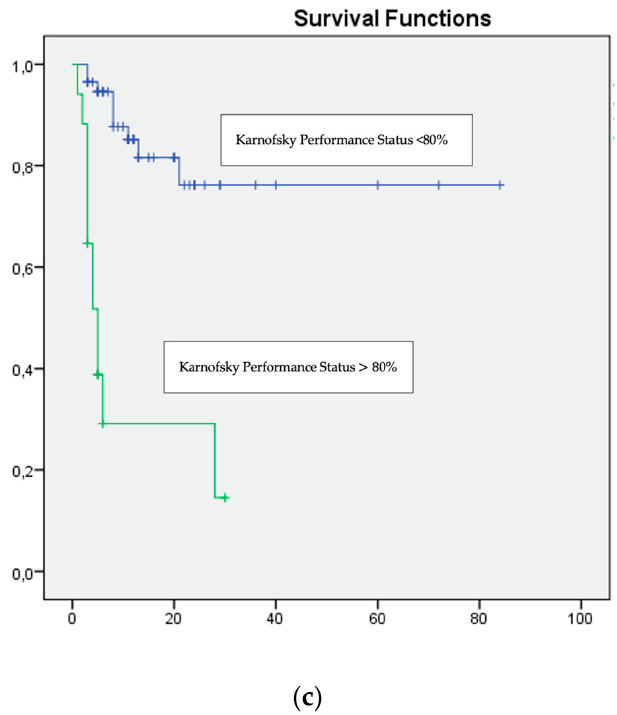
Figure 1. Multivariate analysis: ( a ) NLR ≥ 3, ( b ) Time since diagnosis to treatment <12 months and ( c ) Karnofsky Performance Status <80%, were associated with unfavourable survival.